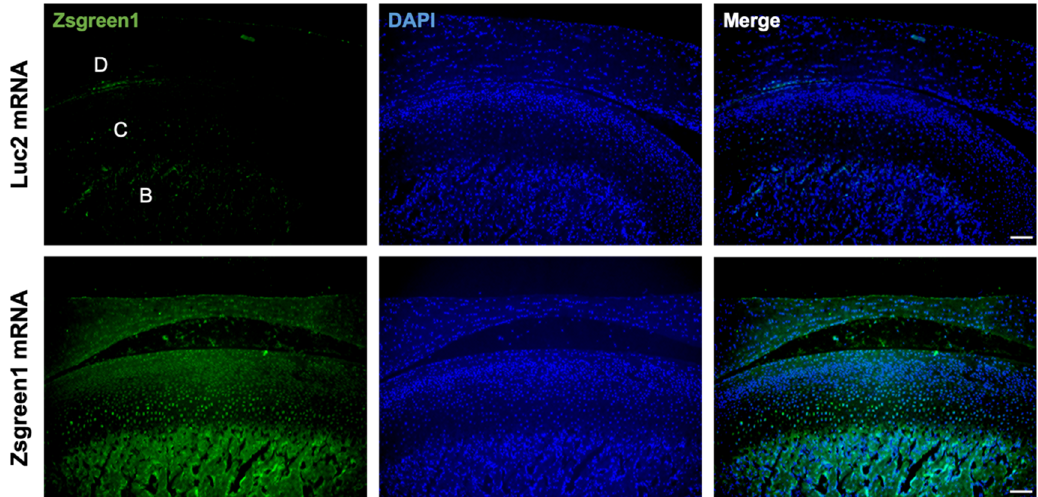
Figure 1. Diffusive ZsGreen1 protein expression from the exogenous mRNA in the temporomandibular joint (TMJ). Representative images after immunofluorescence staining by anti-ZsGreen1 antibody (Green) and DAPI (Blue). D, disc. C, cartilage. B, bone. Scale bar, 100 μ m.